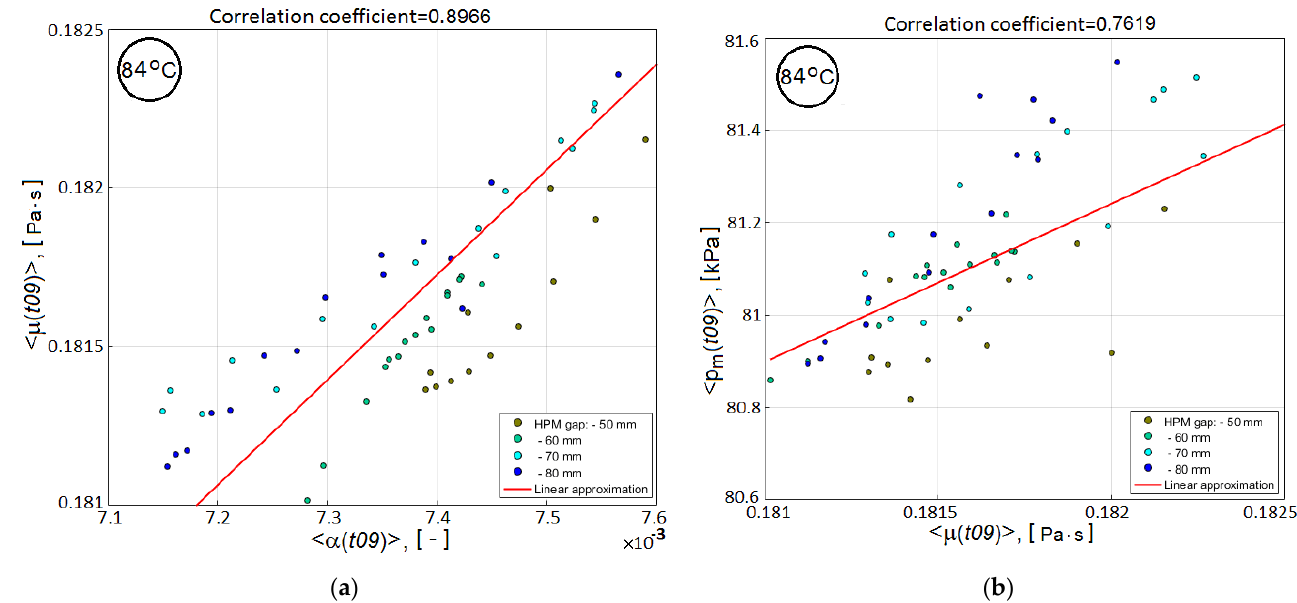
Figure 8. 2D scatter plots showing the cross ‐ correlation between the predictive sub ‐ criteria: ( a )    09 t     09 t     09 tp    09 t  and ; ( b ) and . m ( a ) < µ ( t 09)> and < α ( t 09)>; ( b ) < P m ( t 09)> and < µ ( t